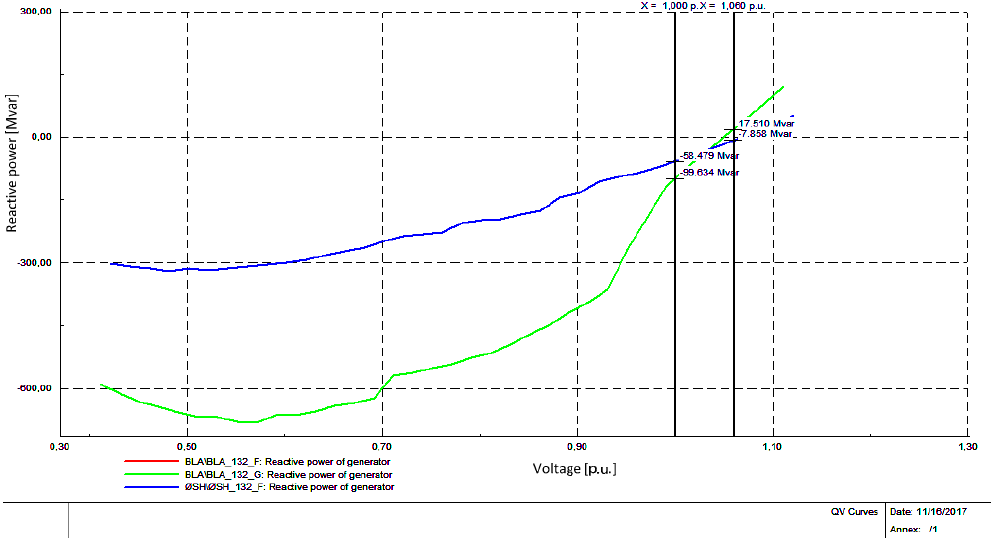
Figure 10. The QV-curves for two substations, BLA and ØSH, in an N-2 Figure 10. The QV ‐ curves for two substations, BLA and ØSH, in an N ‐ 2 situation.